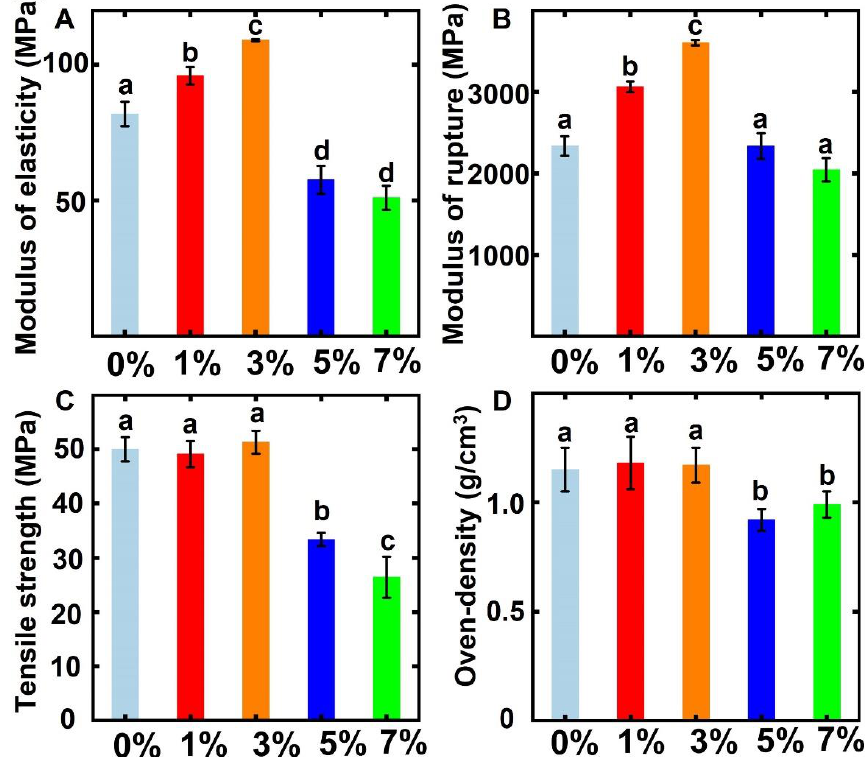
Figure 3. Physical/mechanical properties of PLA/coffee grounds composite 3D printing products: ( A ) modulus of elasticity; ( B ) modulus of rupture; ( C ) tensile strength; ( D ) oven density. The figure shows significant differences between groups ( p < 0.05). The error bar in the figure represents the standard deviation.